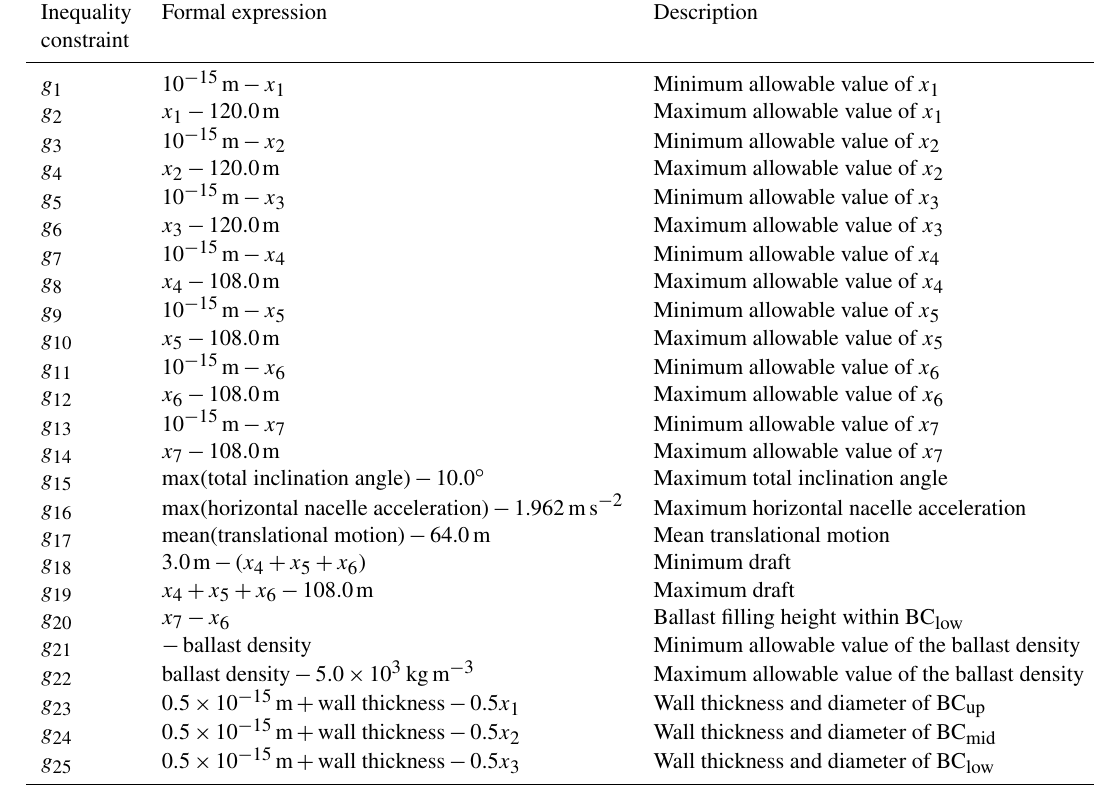
Table 3. Definition of the 25 inequality constraints.